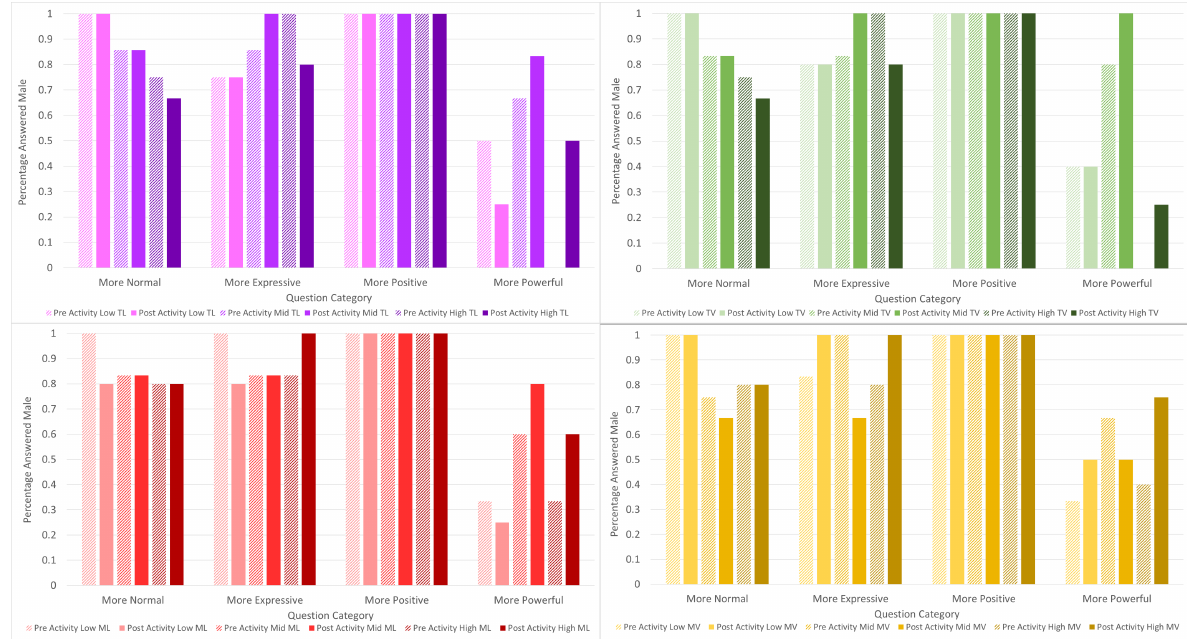
Figure 6: All pairings of Male vs. Phone, showing how many participants rated Male as more normal, more expressive, more positive, and more powerful. These are separated into three levels (Low, Mid, High) of four metrics (Technology Literacy, Technology Valence, Movement Literacy, and Movement Valence). All participants, regardless of level of metric, reported Male as more positive.Low-TL participants rated Male as more normal both before and after the performance. The lowest number of High-TL participants rated Male as more normal. While all High-TL participants chose Phone as more powerful before, half of the High-TL participants chose Male as more powerful afterwards (all High levels of the four metrics show increases in the answer of Male as more powerful